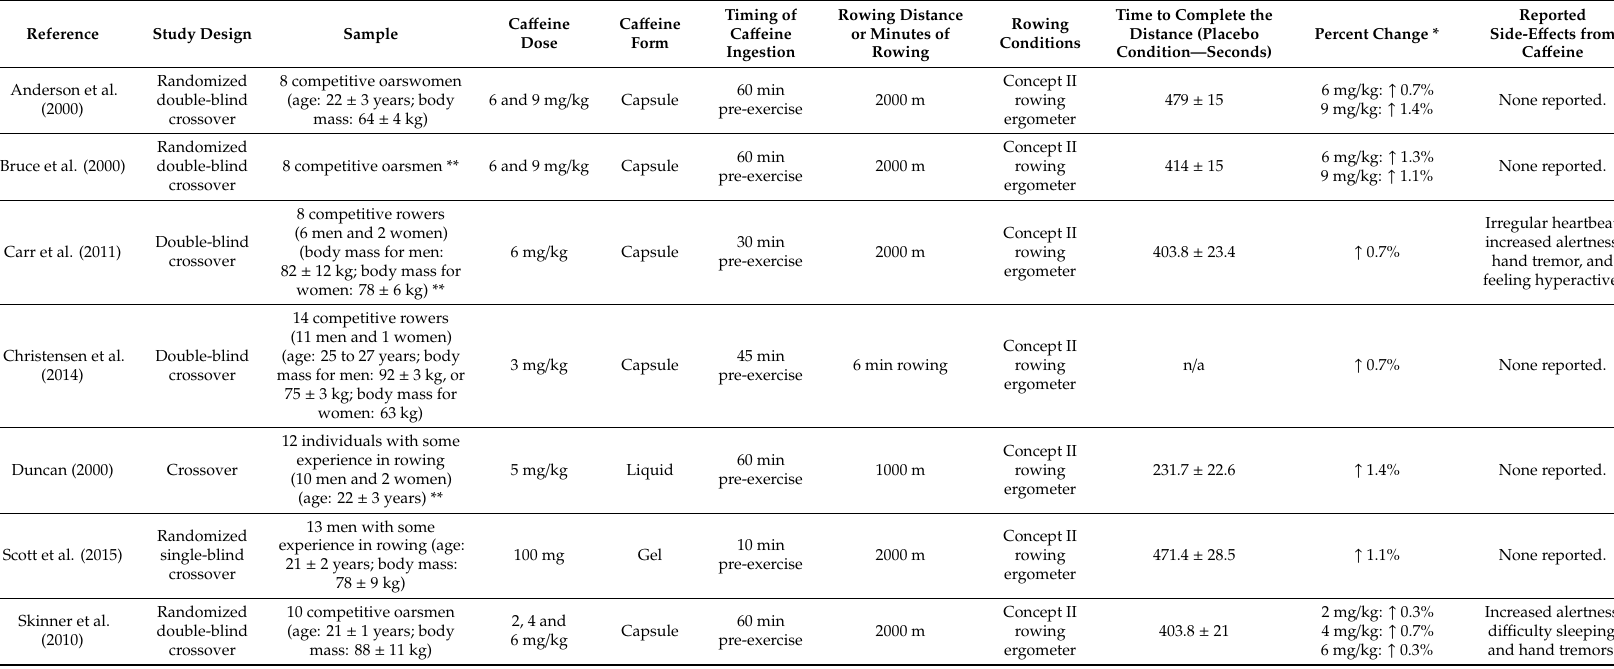
Table 1. Summary of the included